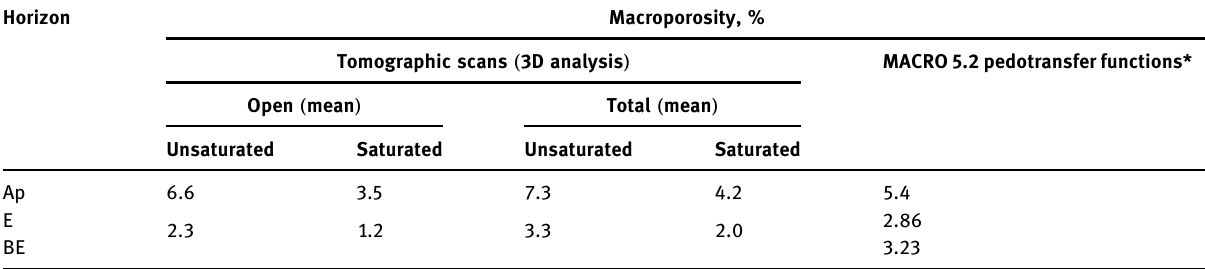
Table 4: Macroporosity of agrosoddy - podzolic soil obtained from tomographic scans and calculated using PTF